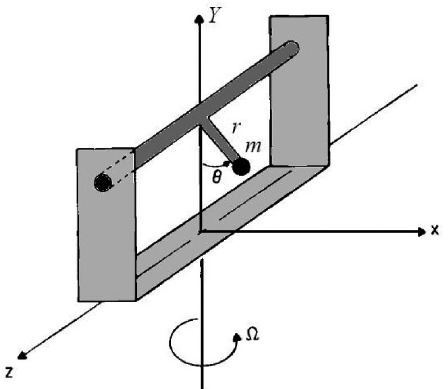
Fig. 1. Geometry of case